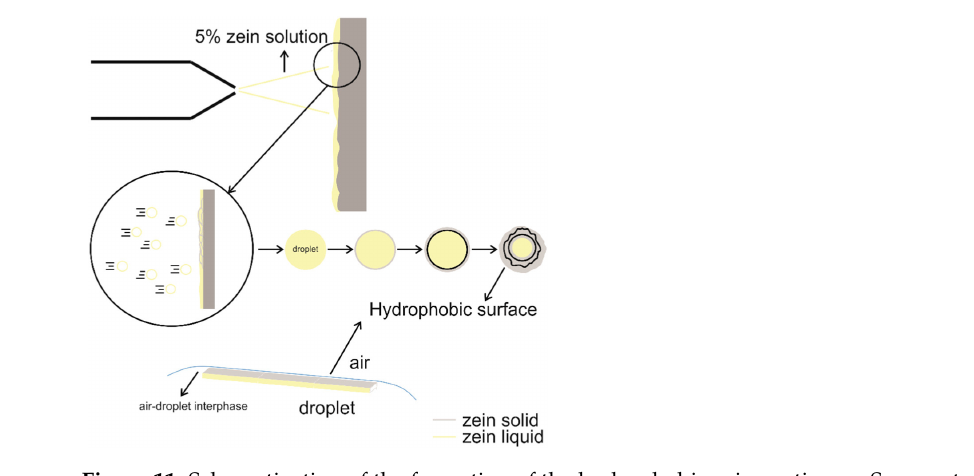
Figure 11. Schematization of the formation of the hydrophobic zein coating on Serena stone by the spray-coating technique. Reprinted with permission from Ref. [65]. Copyright 2021, M. Zucchelli, Progress in Organic Coatings, Elsevier.